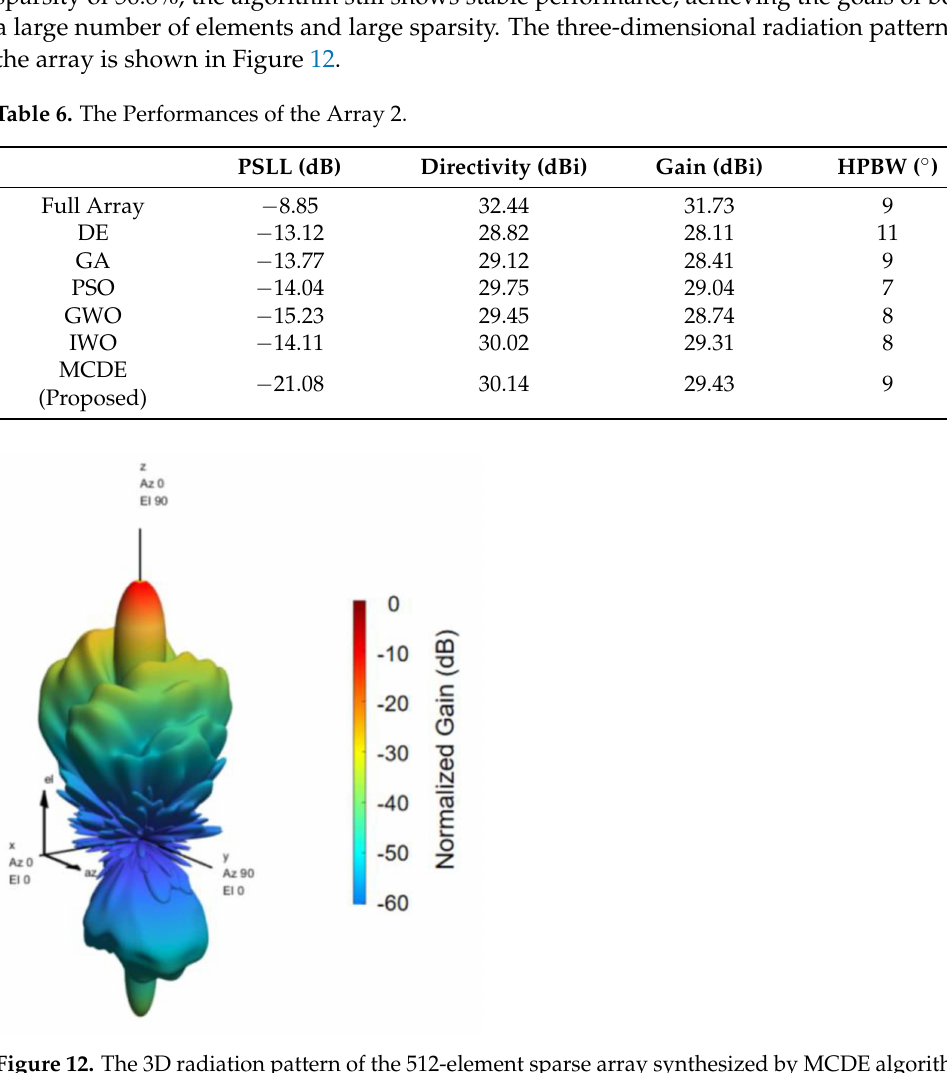
Figure 12. The 3D radiation pattern of the 512-element sparse array synthesized by MCDE